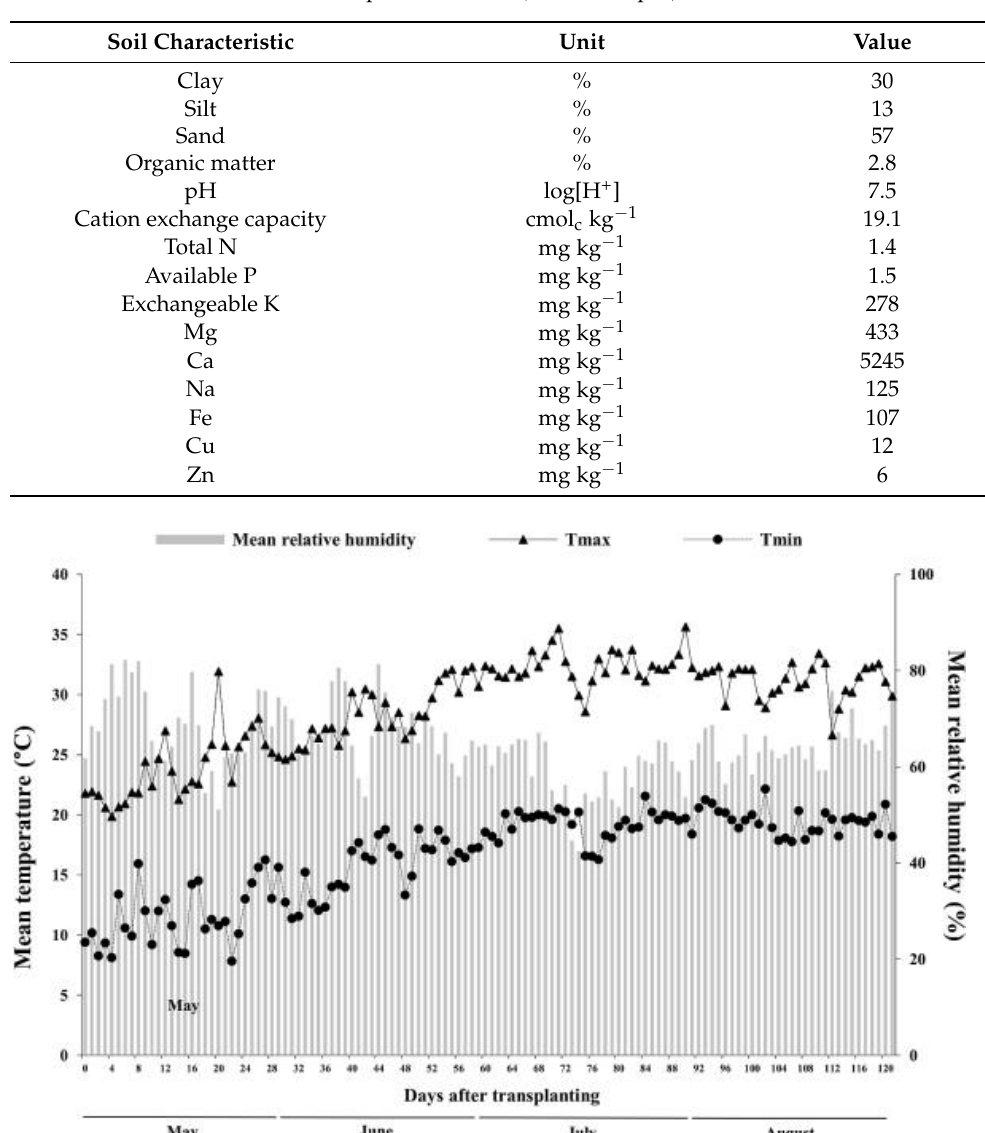
Table 1. Soil characteristics at the experimental site (0–40 cm depth).